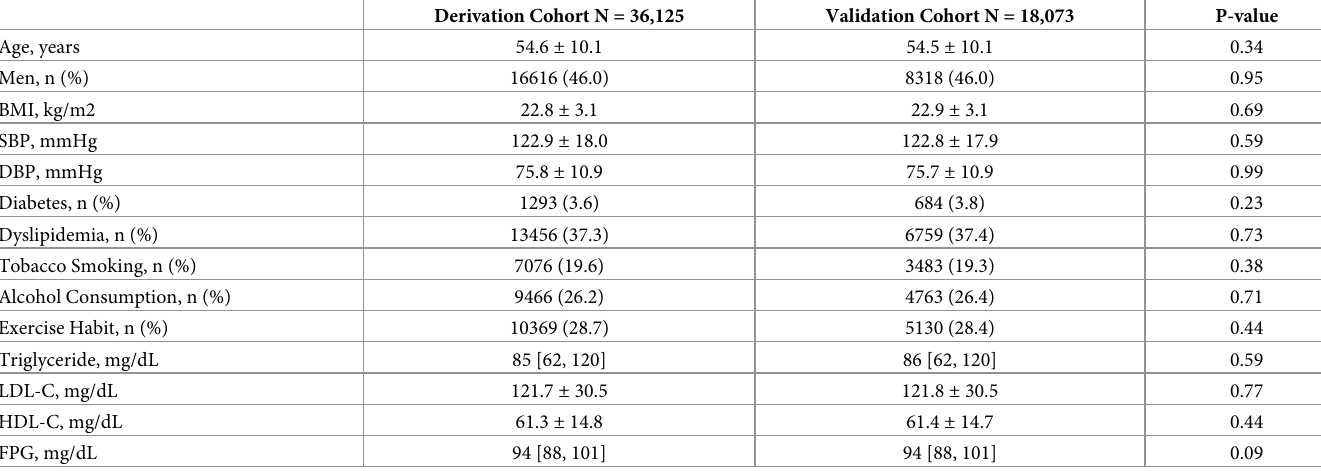
Table 1. Baseline characteristics of the study population in derivation and validation